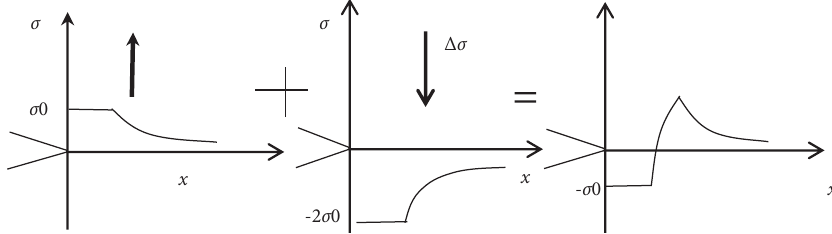
Figure 2: Schematic stress distribution by plastic stress superposition method.